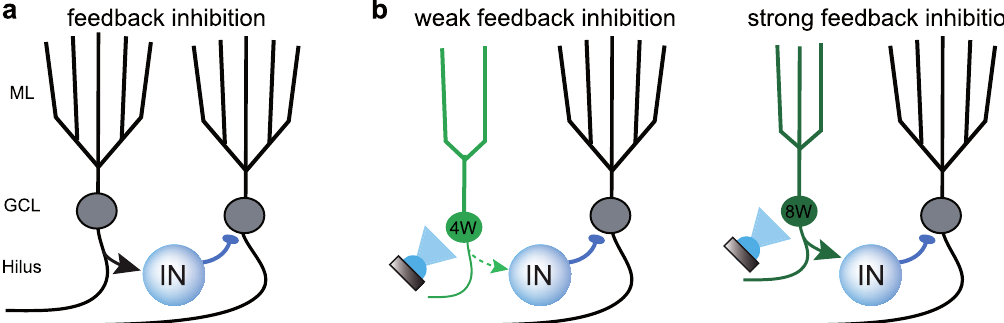
Figure 2. Controlling mature granule cell excitability by feedback inhibition. a . Depiction of feedback inhibition in the dentate gyrus (DG) wherein granule cells (GCs) recruit GABAergic interneurons (IN) that in turn inhibit GCs. Arrows indicate excitatory glutamatergic synapses and circles indicate inhibitory GABAergic synapses. A common feedback motif in the DG is lateral inhibition, where GCs inhibit their neighbors but not themselves 57 . b . Summary of results from Temprana et al. 58 showing optogenetic activation of 4-week-old adult-born GCs (4W) generates little feedback inhibition (left) whereas activation of 8-week-old adult-born GCs (8W) generates effective feedback inhibition. The size of the arrow indicates the relative strength of interneuron recruitment. GCL, granule cell layer; ML, molecular layer.